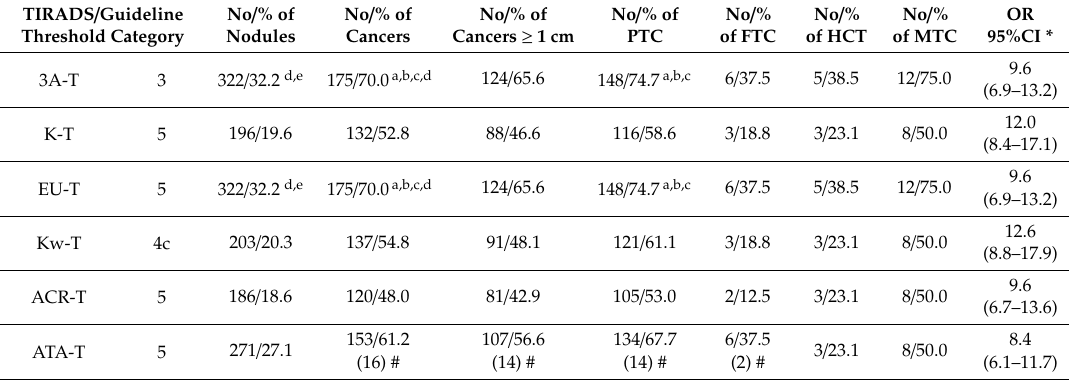
Table 5. Data on the number and percentage of detected cancers in the whole examined sample (for the threshold values that gave the maximum AUC).